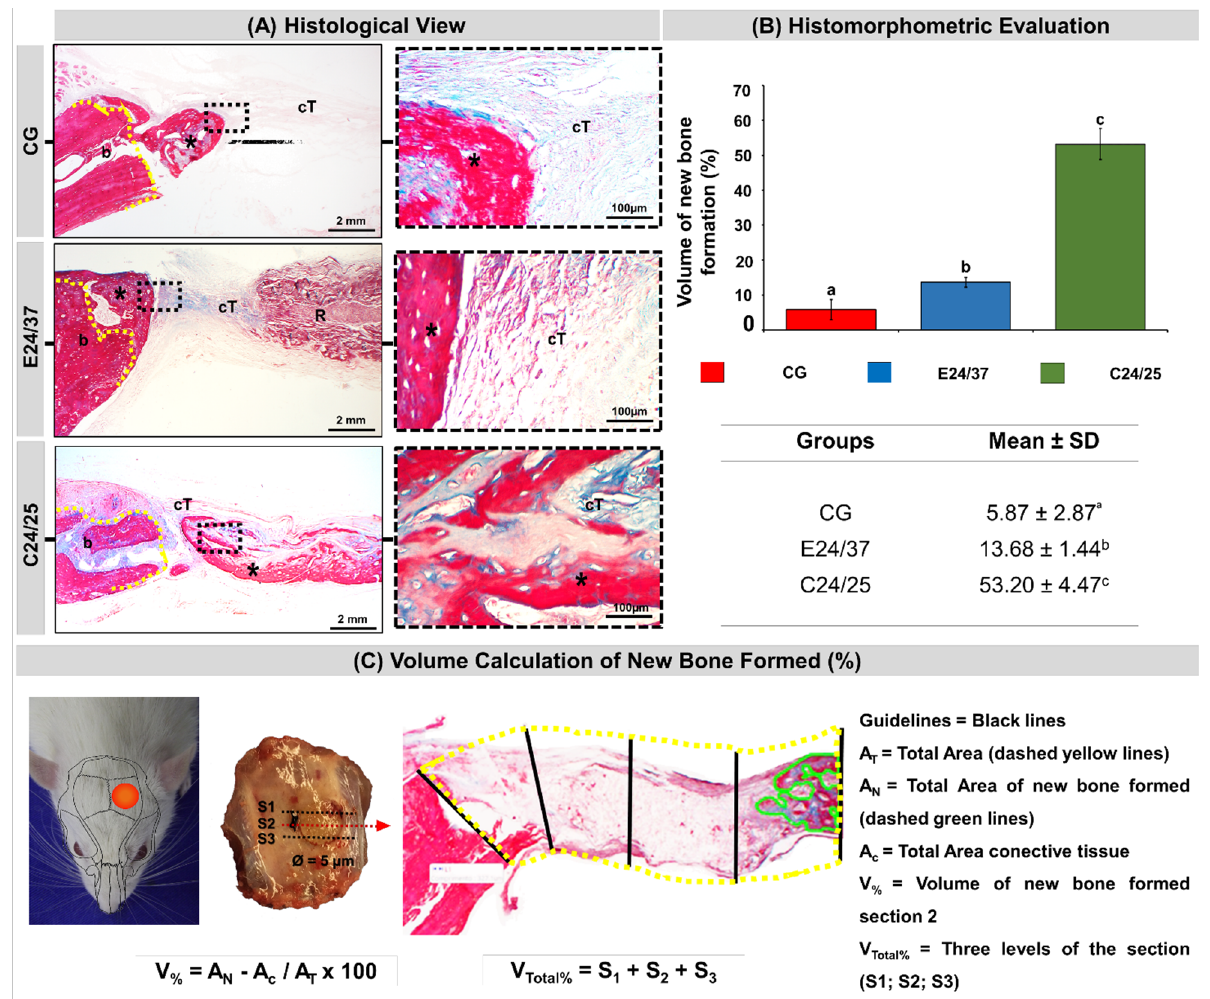
Figure 6. Histological images of the evolution of defects in rat calvarial in the experimental period of 42 days ( A ). Defect without treatment (CG); defect filled with hydrolyzed elastin matrix for 24 h at 37 °C (E24/37); defect filled with collagen matrix derived from hydrolyzed porcine intestinal serosa at 24 h at 25 °C (C24/25). Bone border (b), connective tissue (cT), matrix remnant (R), new bone formed (asterisk), Masson trichrome. Original 10× magnification; bar = 500 µm and inserts, enlarged 40× images; bar = 100 µm. Histomorphometric Evaluation: graph of the volume of new bone formed (%) in each group at 42 days. Table of percentages of new bone formed from all groups: ( B ). Analysis was performed between the different groups (CG, E24/37 and C24/25). ANOVA a criterion followed by the Tukey`s test. Mean ± standard deviation ( n = 10 animals/group), where different letters (a ≠ b ≠ c) indicate statistically significant differences ( p < 0.05). ( B ). Ilustration in the volume calculation of new bone formed (%) of all groups ( C ).